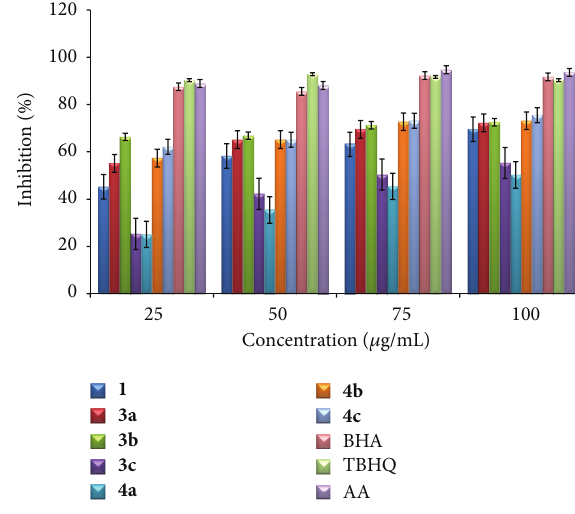
Figure 3: Ferric (Fe 3+ ) ions reducing capacity of the compounds ( 1 and 3-4 ).